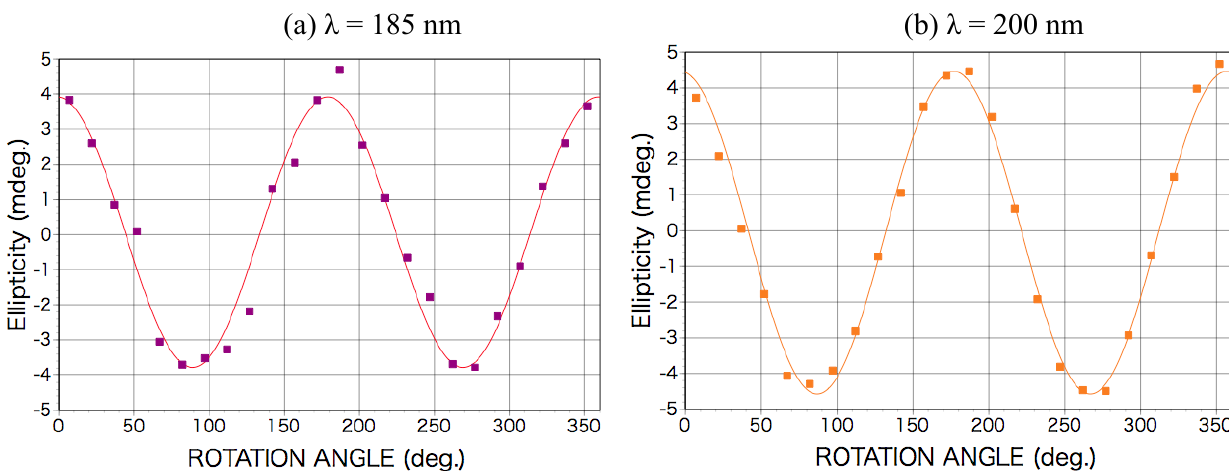
Figure 4. Sample rotation angle θ dependence of CD peak intensity for DL